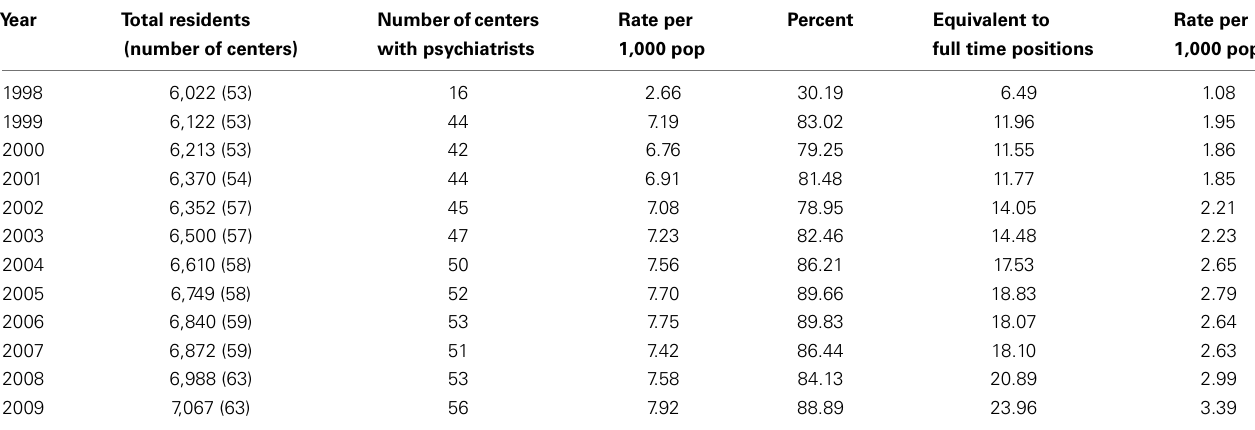
Table 2 |Trends in the number of psychiatrists employed by residential care centers in Israel for people with intellectual